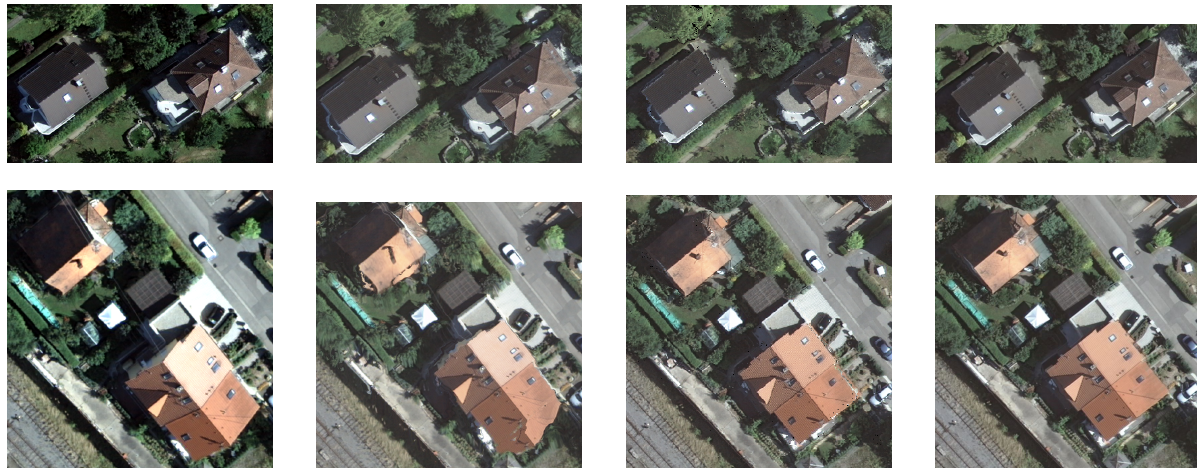
Figure 7: Test area original aerial images (1 st column) vs. orthophoto (2 nd column) vs. true orthophoto (3 rd column) vs. true orthophoto from manually captured DBM (4 th